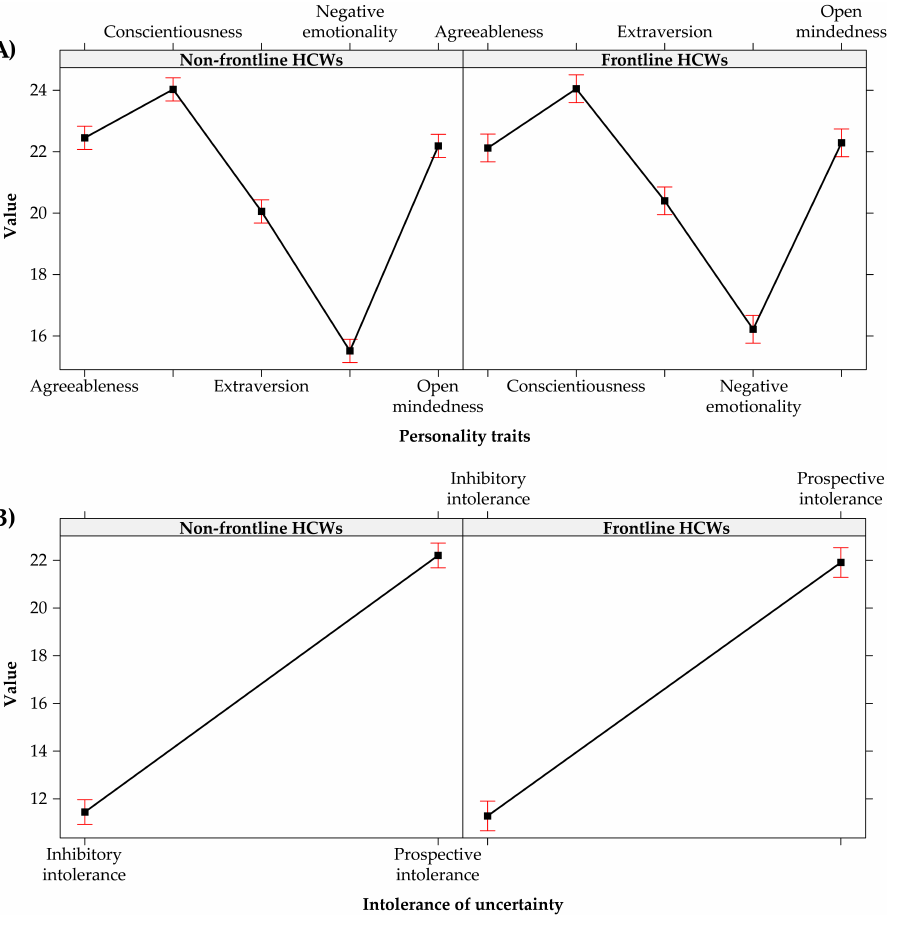
Figure 2. Effect plot of: ( A ) personality traits; ( B ) intolerance of uncertainly. The bars represent the 95%